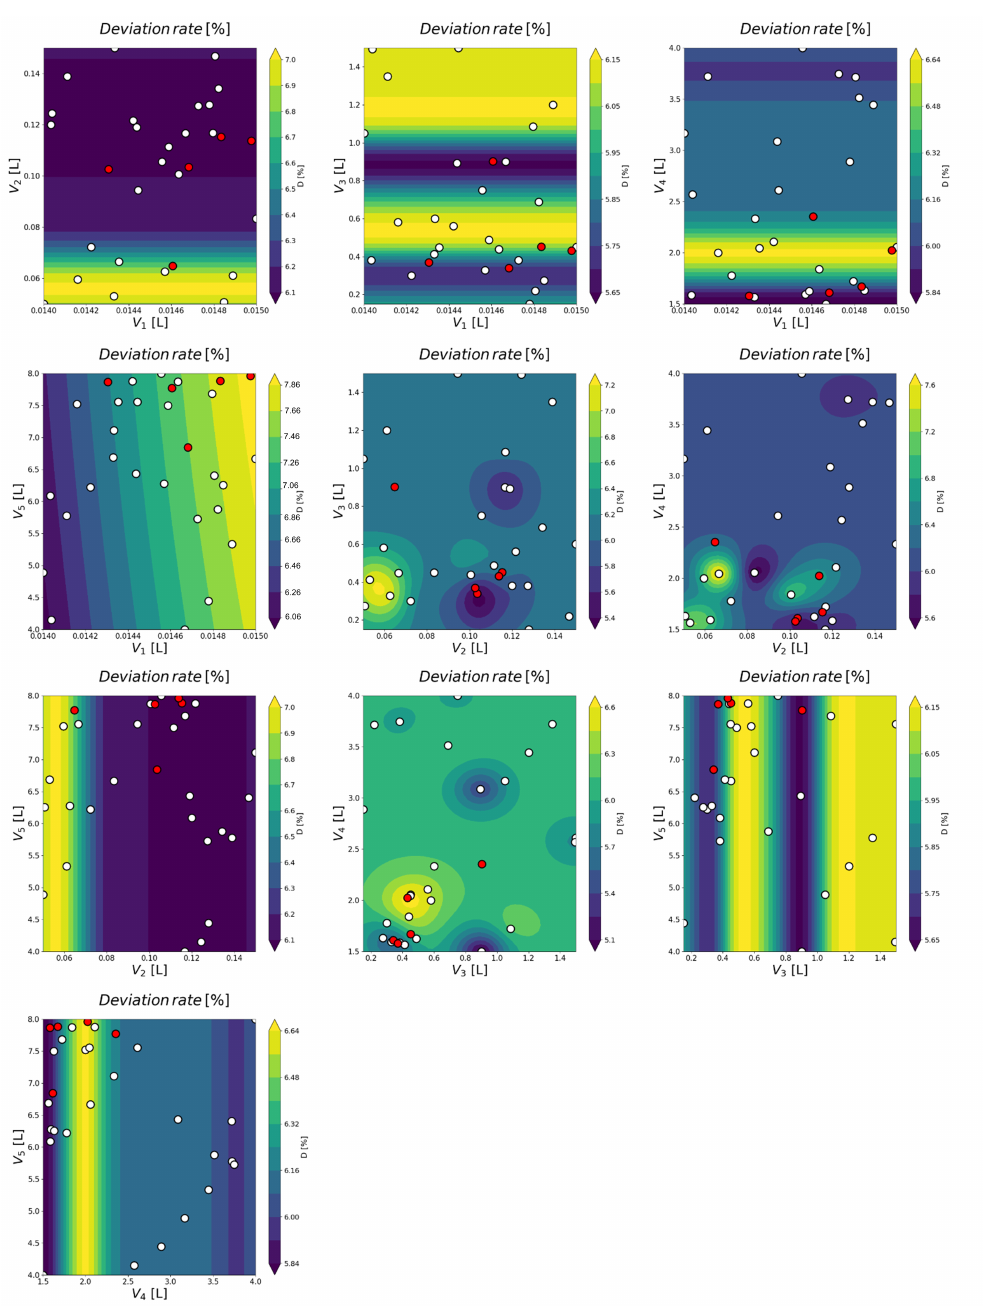
Figure 4. Contour plots showing two optimizable variables on x and y-axis and one objective (here Deviation rate D in %), assigned to each combination of the two variables, through colored isolines. For example, the diagram in the top left shows the deviation rate for each combination of V 1 (filling volume in flask scale 1) and V 2 (filling volume in flask scale 2) through colors representing the corresponding values in %, as indicated on the color bar. Moreover, the results obtained through seed train simulations are shown by dots. The red dots represent the non-dominated (optimal